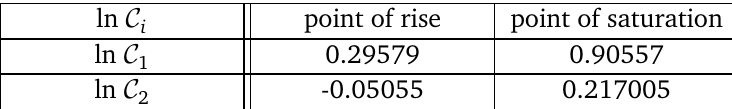
is a = 0.01037 and for it is a = 0.01002 C 1 C 2 is a = 1 and for it is a = 0.495. C 1 C 2